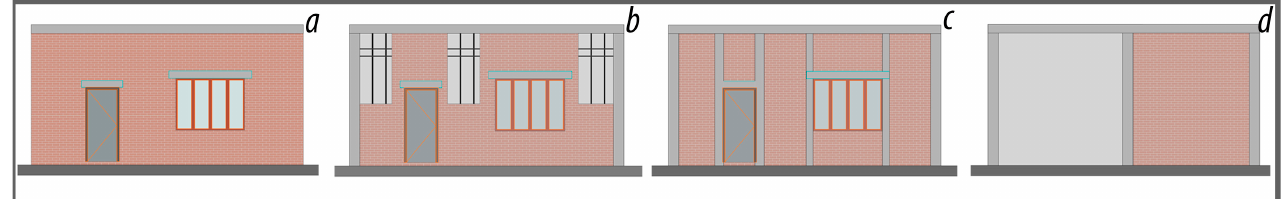
Figure 6. Type of masonry building: ( a ) Unreinforced masonry, ( b ) Reinforced masonry, ( c ) Contained masonry. ( d ) Mixed system (RC frame and masonry wall).